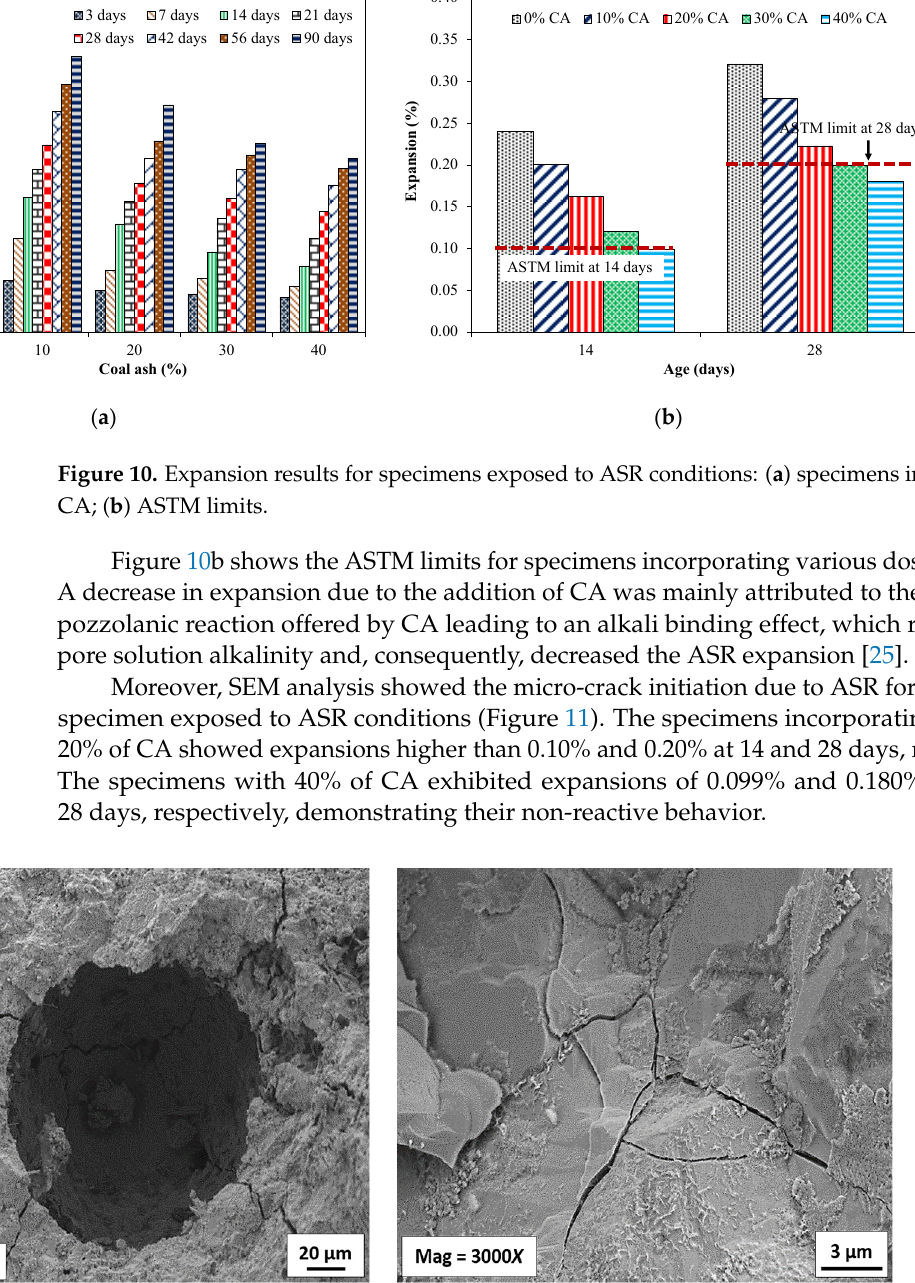
Figure 11. SEM images showing micro-cracks in control specimens without CA and SF exposed to ASR conditions.